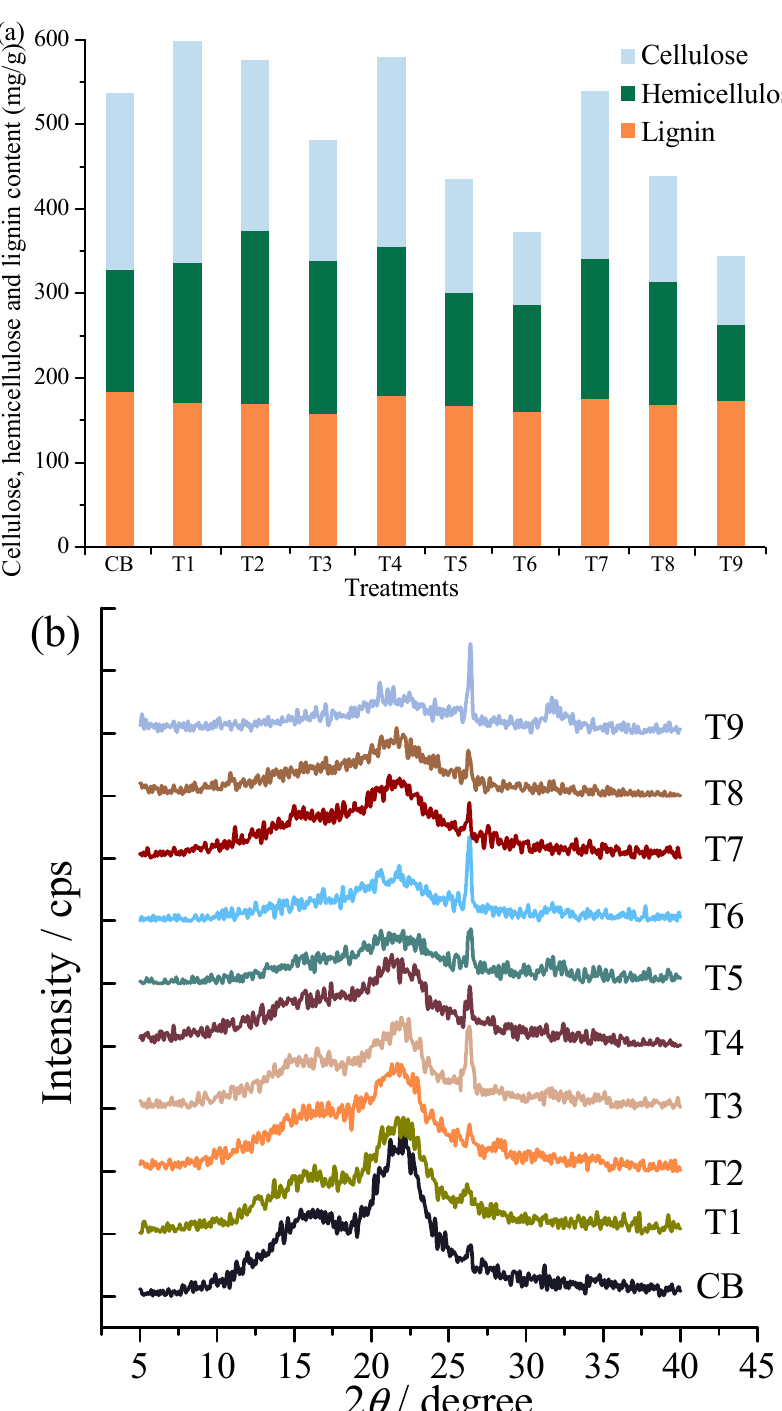
Figure 4. The contents of cellulose, hemicellulose, and lignin ( a ) and the x-ray diffractions ( b ) of the remaining chestnut burrs (CB) at the end of composting (CB: initial chestnut burrs, T1–T9: the remaining CB in treatments T1–T9).